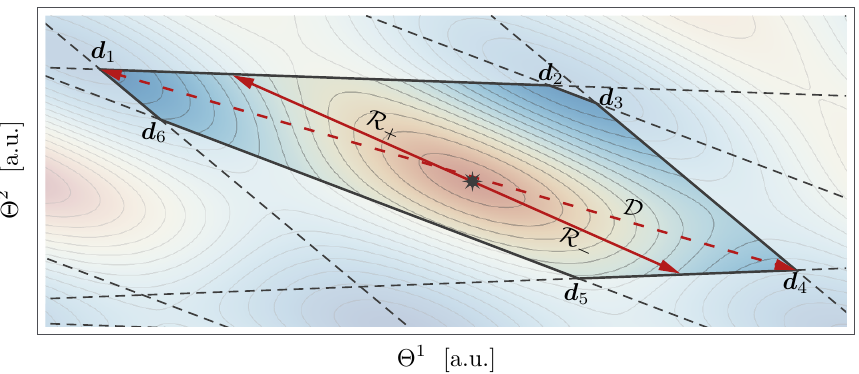
Figure 11 . Illustration of the tile The solid arrows denote the (cid:12)eld ranges minimum, while the dashed arrow denotes the diameter